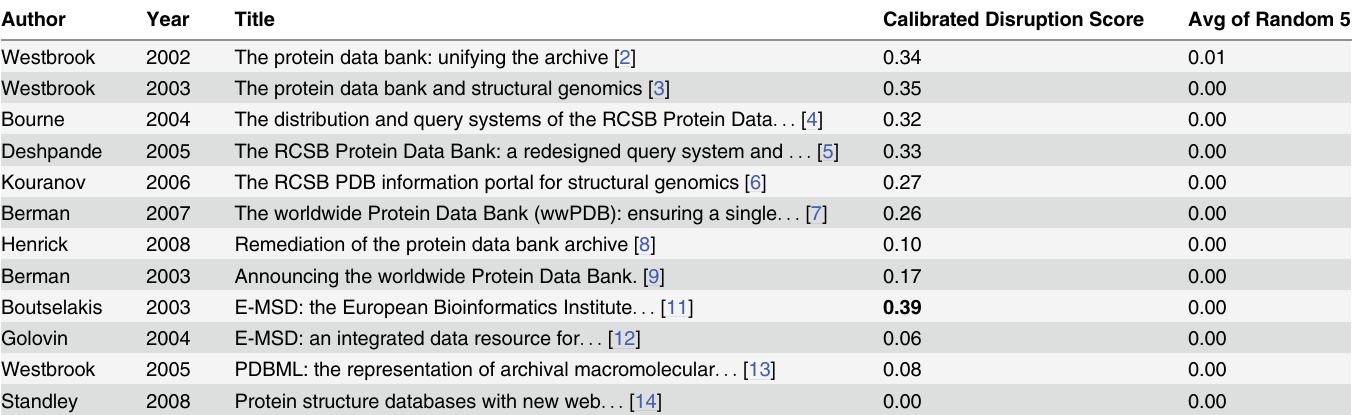
Table 2. 5-year calibrated disruption scores of the PDB follow-up articles. The last column shows the average scores of randomly selected papers pub- lished in the same issue.